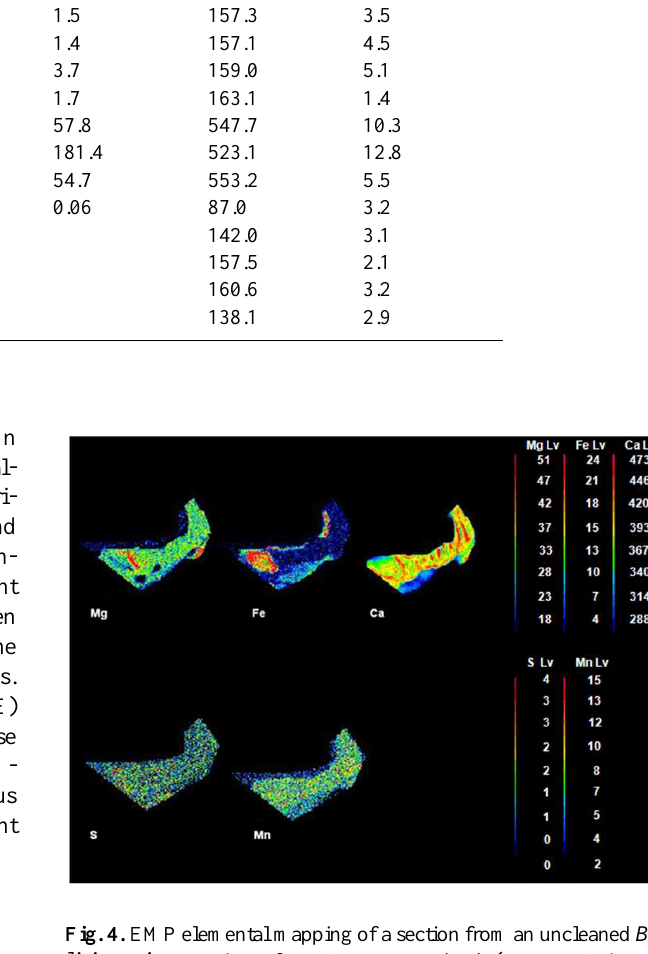
Fig. 4. EMP elemental mapping of a section from an uncleaned Bo- livina spissa specimen from 640m water depth (M77-1-565/MUC- 60) on an exposed section of the foraminiferal test. Distribution of Mg, Fe, Mn, S and Ca in the foraminiferal test. All intensity val- ues are expressed in counts per second (cps) as shown in the color bars. Note that the Fe distribution shows a contaminant phase a the inner part of the test walls similar like the uncleaned specimens of U. peregrina